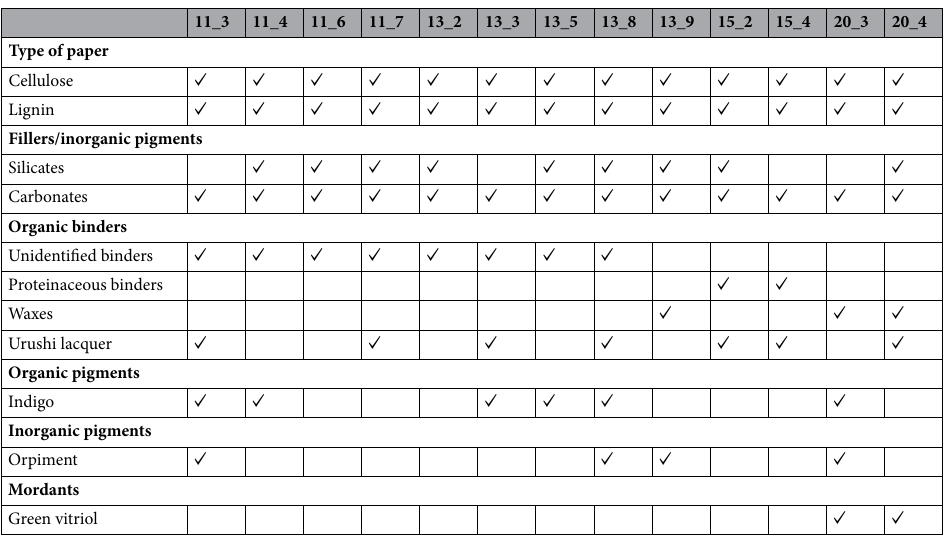
Table 2. Organic and inorganic substances detected through μATR-FTIR performed on INV_11, INV_13, INV_15, and INV_20. ✓ indicates the presence of the substance within the sampling point; for clarity, “INV_X_” (X = 11, 13, 15, or 20) was omitted from the sampling points’ acronyms.